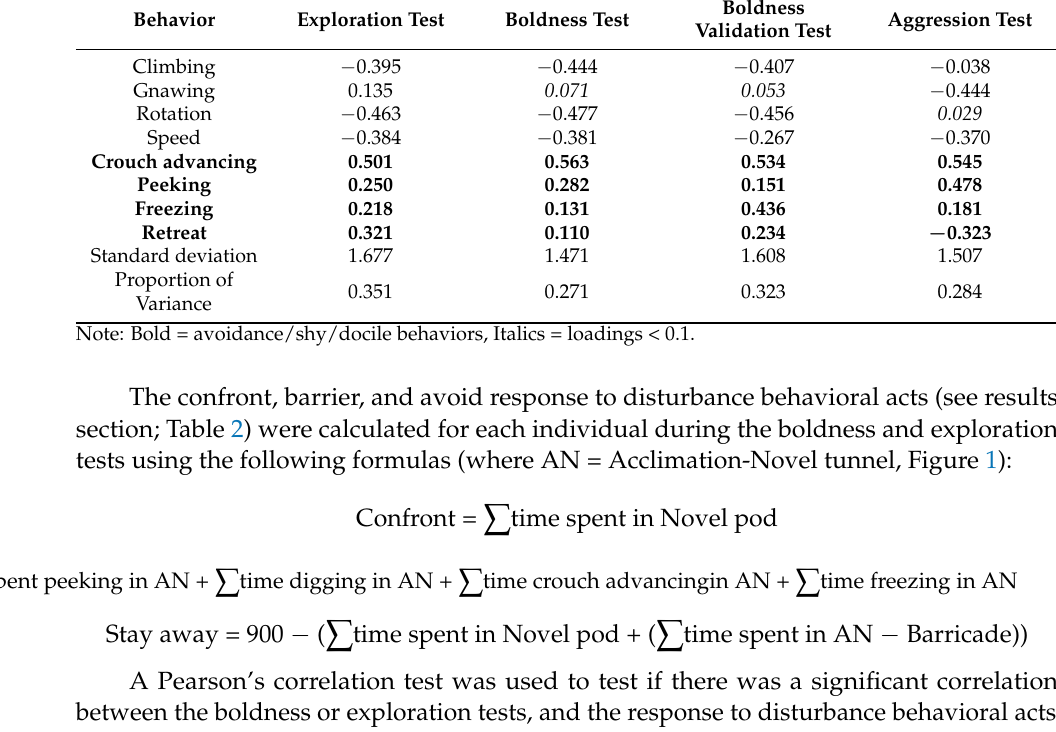
Table 2. First principal component analysis loadings for each behavior for each personality test. Behavior Exploration Test Boldness Test Climbing − 0.395 −